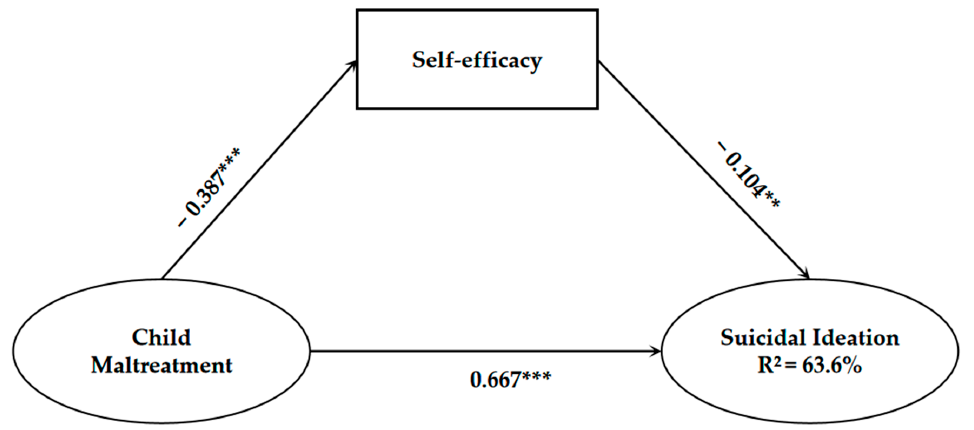
Figure 2. Results of structural model (*** p < 0.001; ** p < 0.01). Among all the control variables, gender ( β = 0.178, p < 0.001), household registration ( β = 0.190, p < 0.001), and single-parent status ( β = 0.080, p < 0.05) have significant effects on left-behind children’s suicidal ideation. Specifically, the female left-behind children have stronger suicidal ideation compared to the males. The left-behind children with urban household registration have stronger suicidal ideation than the rural ones.